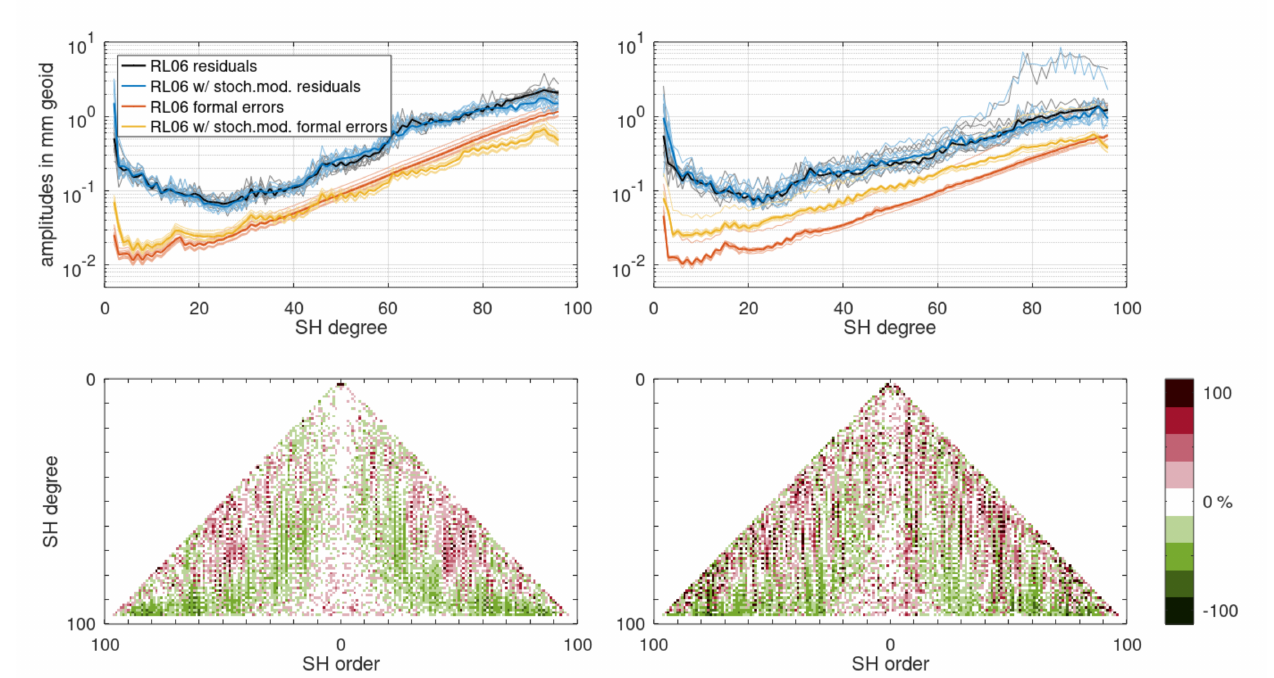
Figure 8. Comparison of the standard GRACE GFZ RL06 solution and a solution with the application of the combined ACC and MWI a priori stochastic model for 2007 ( left ) and 2014 ( right ). ( Row 1 and 2 ) Logarithmic scaled formal error median of all monthly solutions for the standard RL06 solutions ( Row 1 ) and those with the a priori stochastic model applied ( Row 2 ). ( Row 3 ) Median of SH degree amplitudes (thick lines) of the monthly residuals (thin lines are the monthly residual amplitudes) reduced by a GRACE climatology model (Equation (4)) and related formal errors for the standard RL06 solutions (black and red), and those with the a priori stochastic model applied (blue and yellow) in mm geoid height. ( Row 4 ) Relative residual RMS change in % of the solutions with stochastic modeling compared to the standard RL06